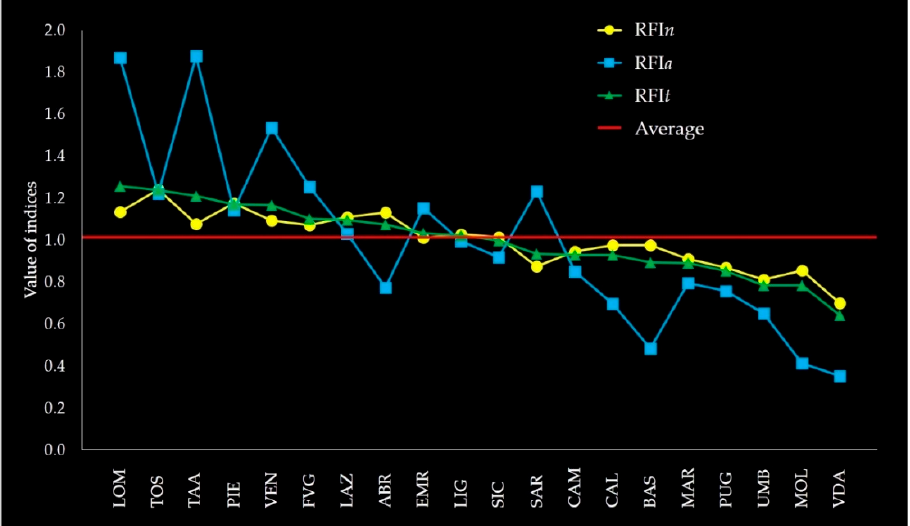
Figure 4. Trend of the regional floristic index applied only to only native taxa (RFI n , yellow curve), only alien taxa (RFI a , blue curve) and the total taxa (RFI t , green curve) currently present in each Italian region (ordered according to RFI t values: LOM: Lombardia; TOS: Toscana; TAA: Trentino-Alto Adige; PIE: Piemonte; VEN: Veneto; FVG: Friuli-Venezia Giulia; LAZ: Lazio; ABR: Abruzzo; EMR: Emilia-Romagna; LIG: Liguria; SIC: Sicilia; SAR: Sardegna; CAM: Campania; CAL: Calabria; BAS: Basilicata; MAR: Marche; PUG: Puglia; UMB: Umbria; MOL: Molise; and VDA: Valle d’Aosta). The red line represents the average number of only native, only alien and total taxa present in all regions (i.e., RFI = 1). Values of RFI n , RFI a and RFI t for each region are available in Table S4. Taxa reported by mistake and as doubts, data deficient, extinct and no longer recorded after 1950 are not counted.